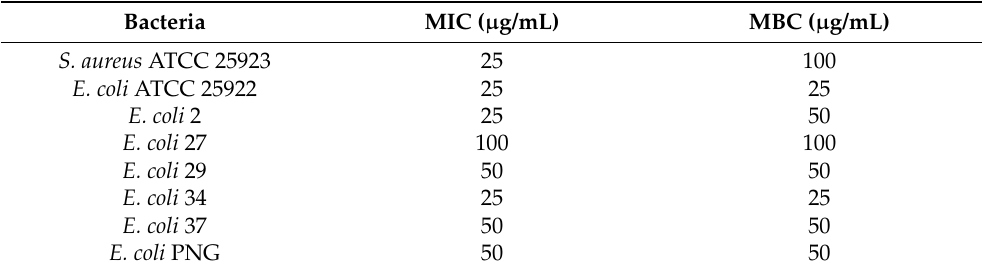
Table 2. Minimum inhibitory concentration (MIC) and minimum bactericidal concentration (MBC) of bacteria treated with SPw-AgNPs.